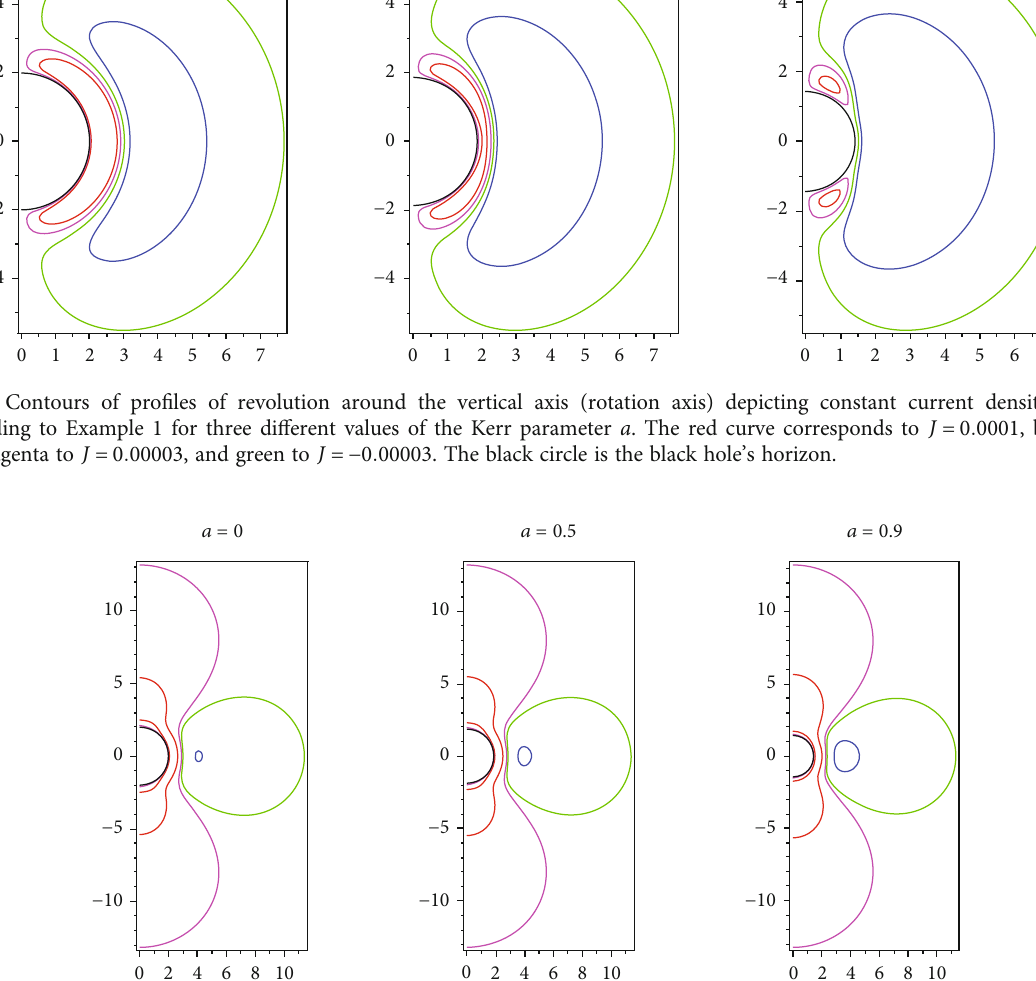
Figure 2: Contour plots of constant charge density lines according to (35). They correspond to the assumptions given in Example 1 for three di ff erent values of the Kerr parameter a . Red lines are for ρ = 0 : 0008 , blue for ρ = − 0 : 0008 , magenta for ρ = 0 : 0001 , and green for ρ = − 0 : 0001 ; the black curve represents the black hole ’ s